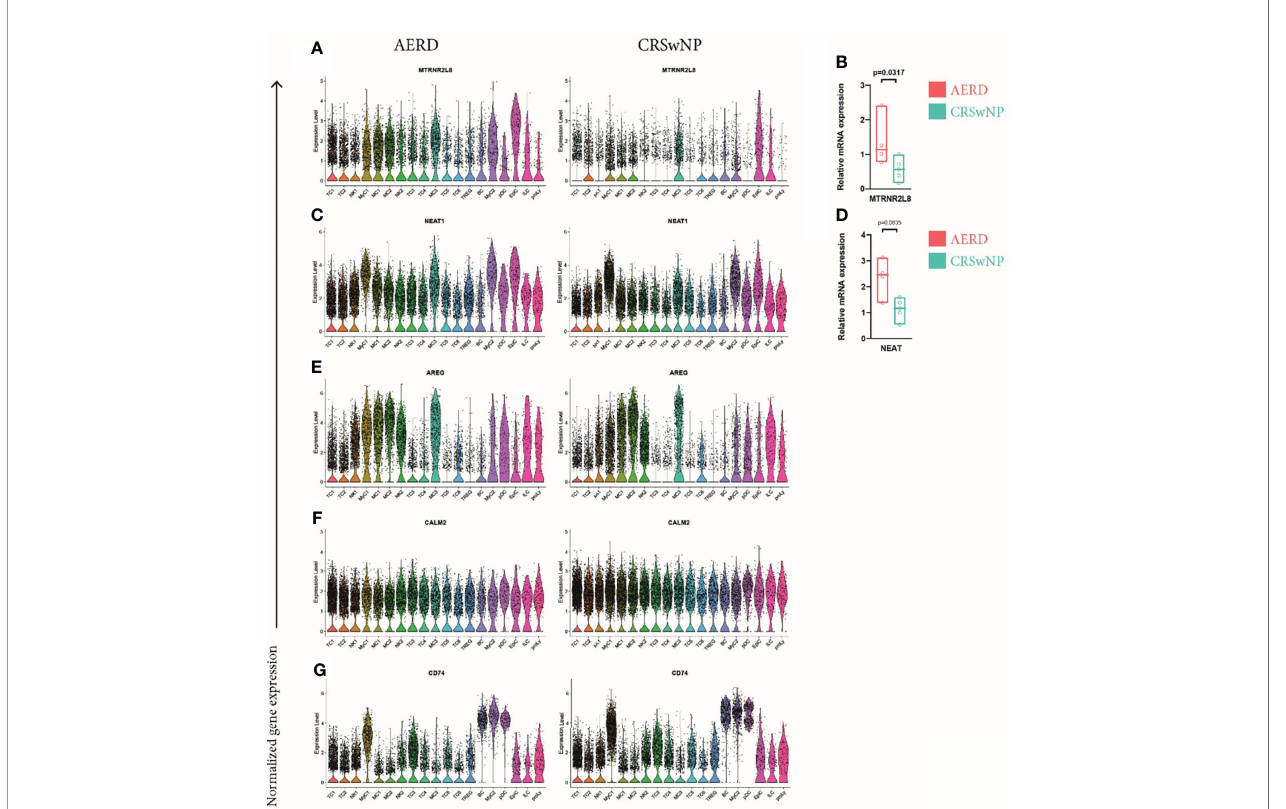
FIGURE 7 | Differentially expressed genes comparing all cell clusters of AERD and CRSwNP. Color-coded violin plots showing natural log-transformed normalized gene expression for (A) MTRNR2L8 , (C) NEAT1 , (E) AREG , (F) CALM2 , and (G) CD74 in all cell clusters of (left) AERD as compared to (right) CRSwNP. Quantitative real-time PCR of bulk nasal tissue isolates for (B) MTRNR2L8 and (D) NEAT1 con fi rming scRNA-seq data. Line represents median values, and p-values are indicated in plots. AERD, aspirin-exacerbated respiratory disease; CRSwNP, chronic rhinosinusitis with nasal